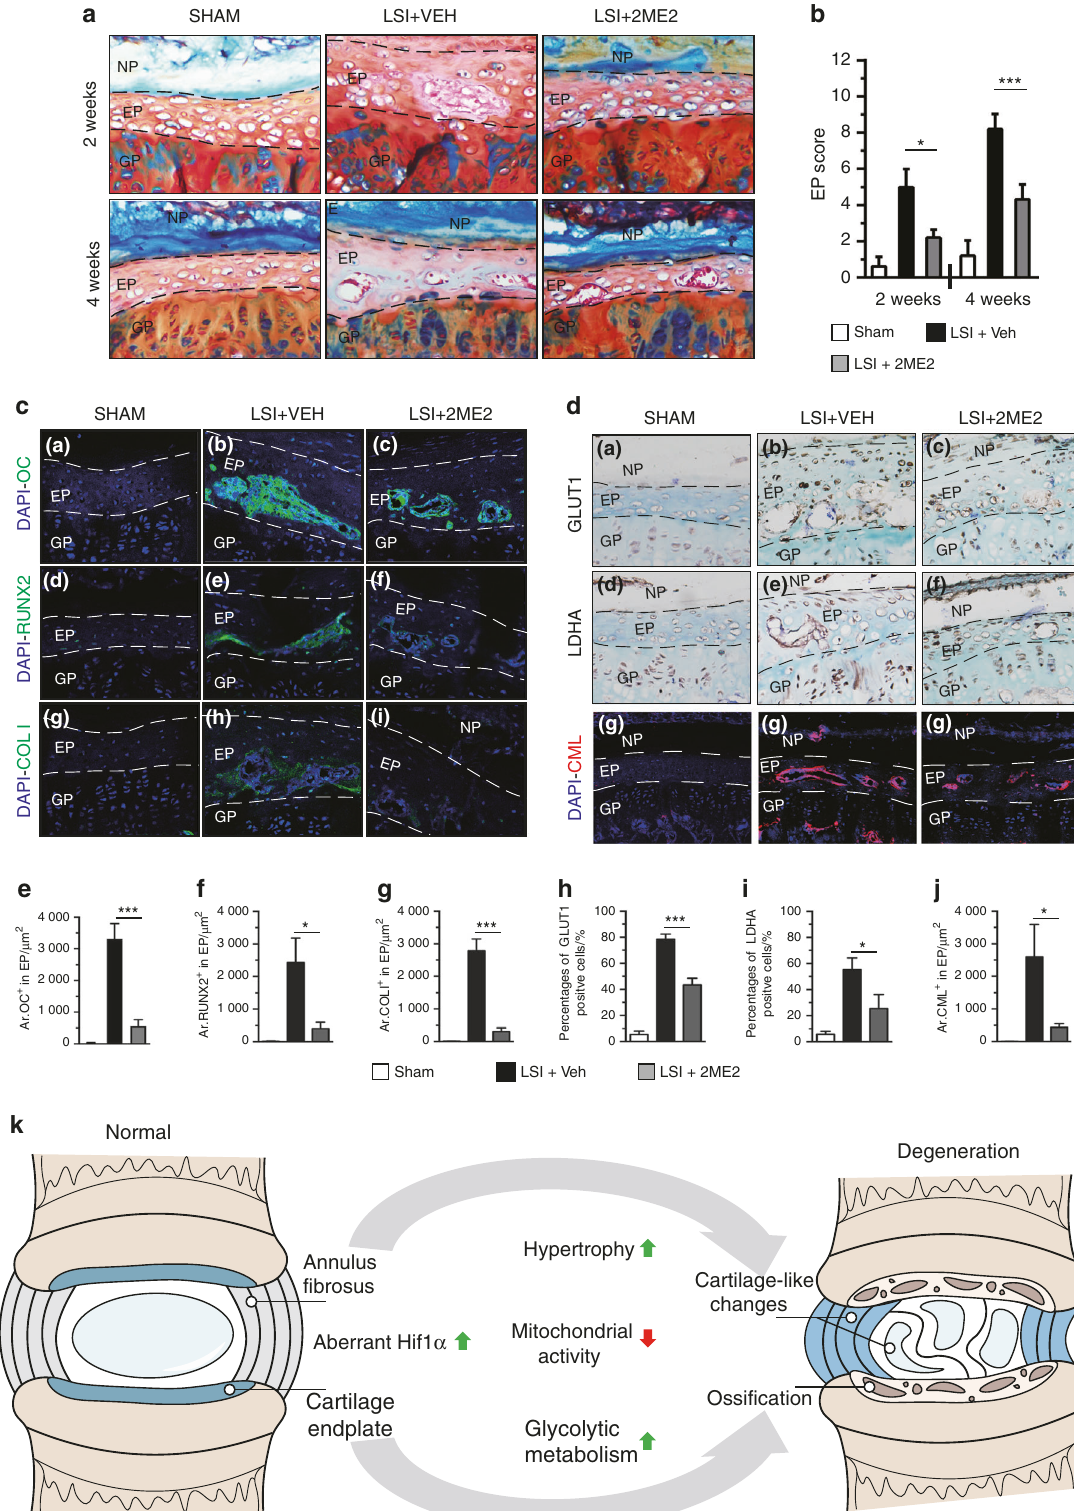
Fig. 8 Pharmacologic inhibition of Hif1 α attenuates experimental IVD degeneration. a IVD samples were harvested at 2 and 4 weeks post LSI surgery and analyzed histologically by Safranin O/Fast green/alcian blue staining. b Histological degenerative scores of EP tissue. c Immuno fl uorescence detection and e – g quantitative analysis of OC, RUNX2, and COLI expression were performed in lumbar discs of mice at 4 weeks post LSI surgery ( n = 3 per group). d Immunostaining and h – j quantitative analysis of GLUT + cells, LDHA + cells and CML + cells (red) in lumbar discs ( n = 3 per group). k Schematic diagram of the mechanisms underlying the roles of aberrant HIF1 α signaling in DDD pathogenesis. Scale bar: 50 µm ( a , c , d ). Data are expressed as the percent expression relative to controls. Values represent the mean (symbols) ± SD (error bars). *P < 0.05 ; **P < 0.01 ; ***P < 0.001